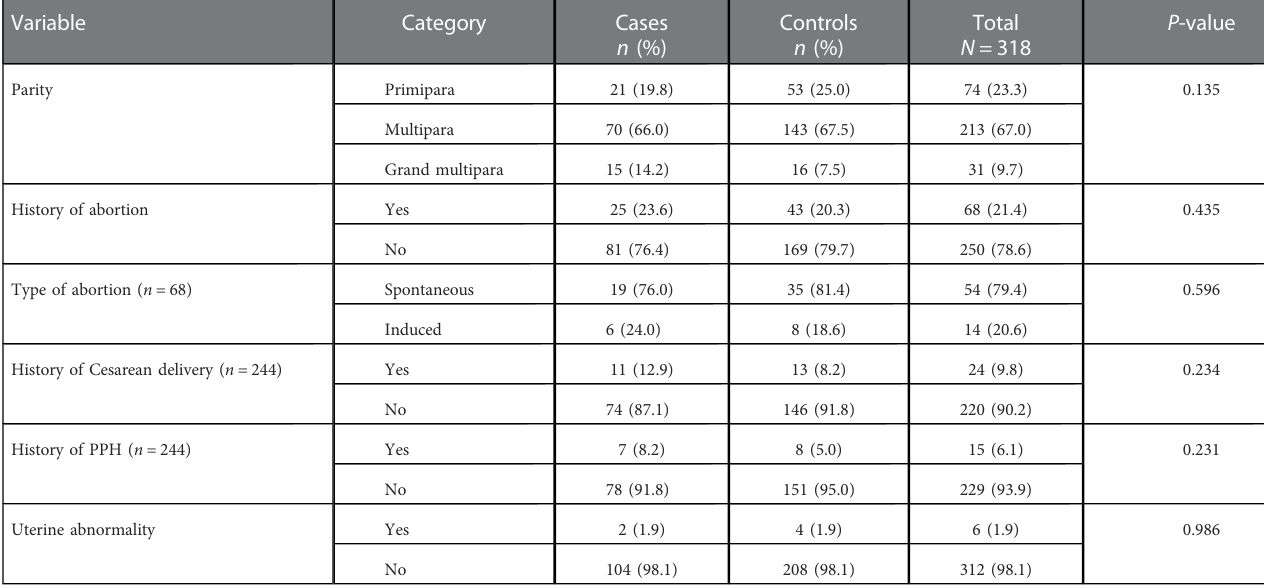
TABLE 2 Obstetrics and gynecologic history of study participants with and without primary postpartum hemorrhage in the public hospital of southern Tigray, Ethiopia, 2019.